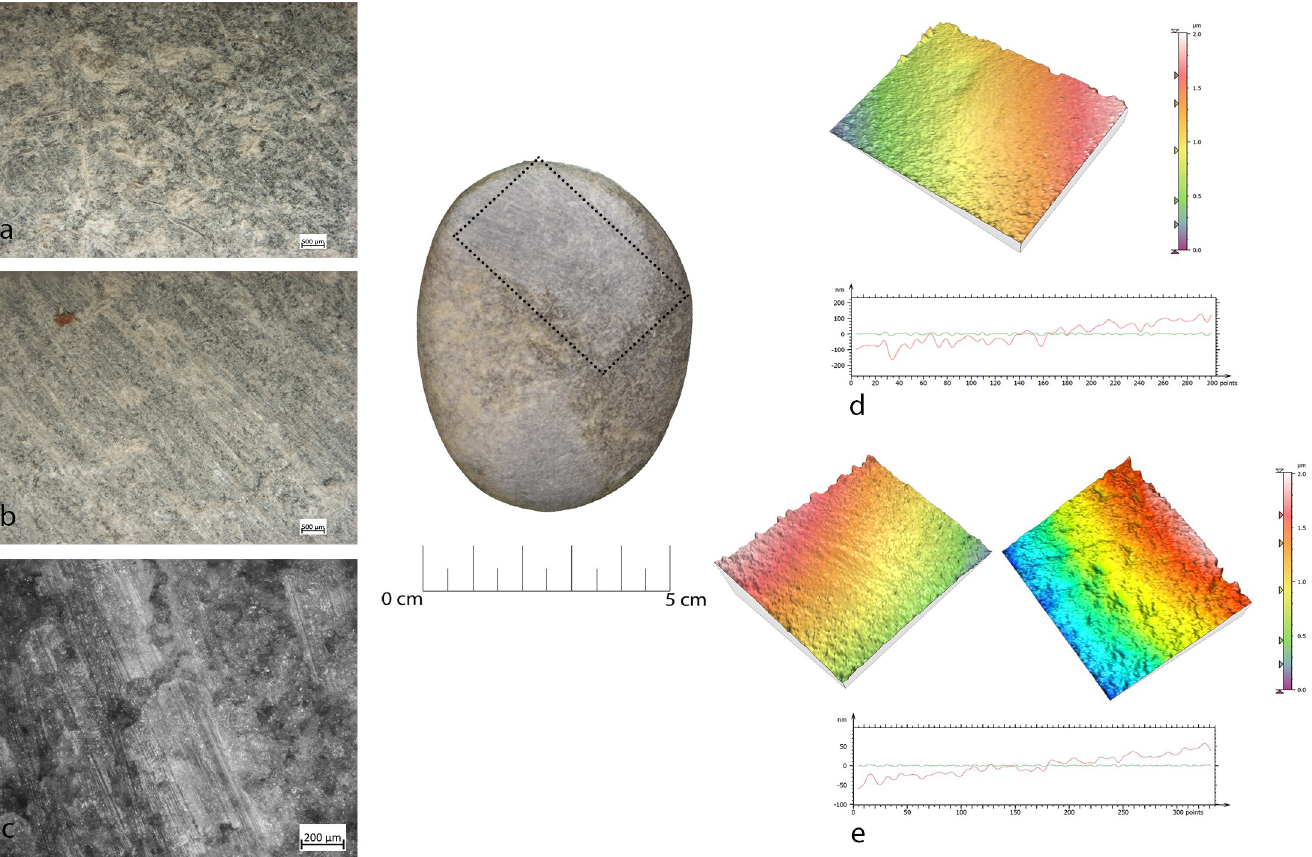
Fig 11. FRP-1 use wear on experimental replica used in marginal retouch. (a) Macro-traces highlight area characterized by a concentration of micro-pits (25x) with sub-circular morphology; (b) long striation (20x) associated with the pits and with the same orientations; the traces are located in apical top with oblique orientation; (c) micro-traces (200x), band of polishes with striations, covered-closed distribution, rough texture and domed topography; (d) 3D microtopography of the unused surface and profile; (e) 3D microtopography of the used surface and profile (striations and